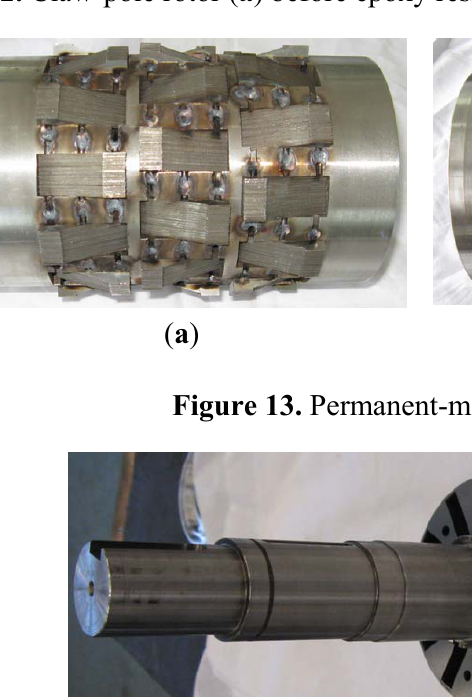
Figure 12. Claw-pole rotor ( a ) before epoxy resin casting; ( b ) after epoxy resin casting.